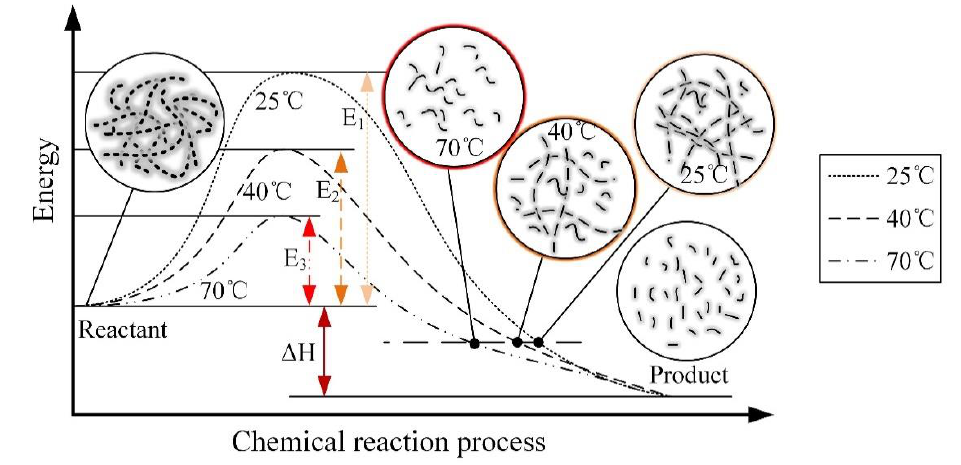
Figure 9. The e ff ect of ambient temperature on mechanical force Figure 9. The effect of ambient temperature on mechanical force chemistry.